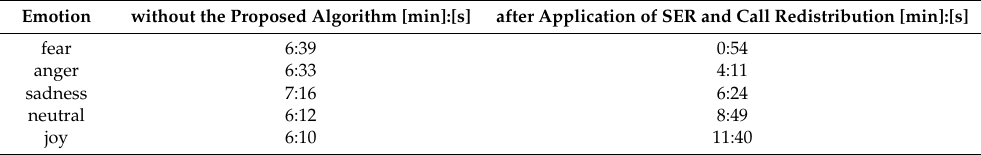
Table 4. Average waiting time when 7 calls are received simultaneously while all operators are busy. Emotion